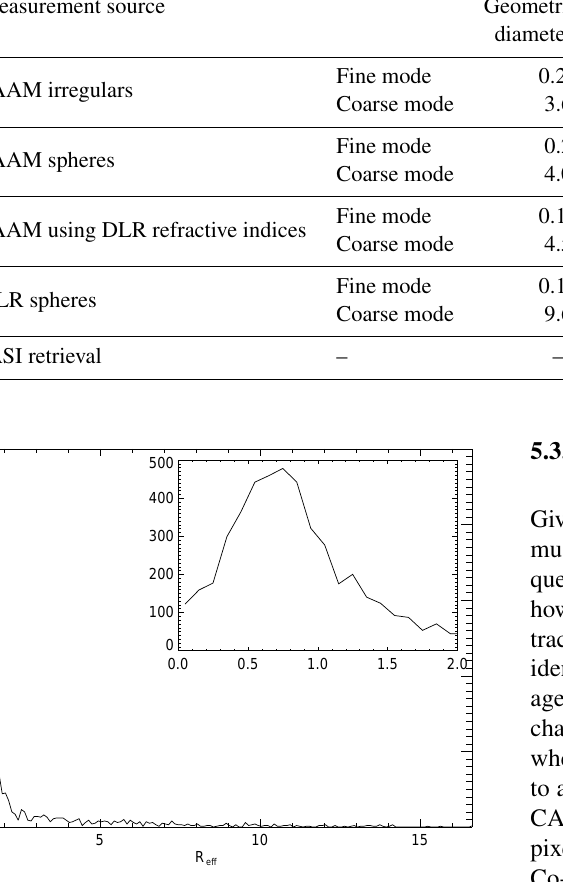
Figure 7. A histogram of the effective radius retrieved in the IASI scenes on 17 May